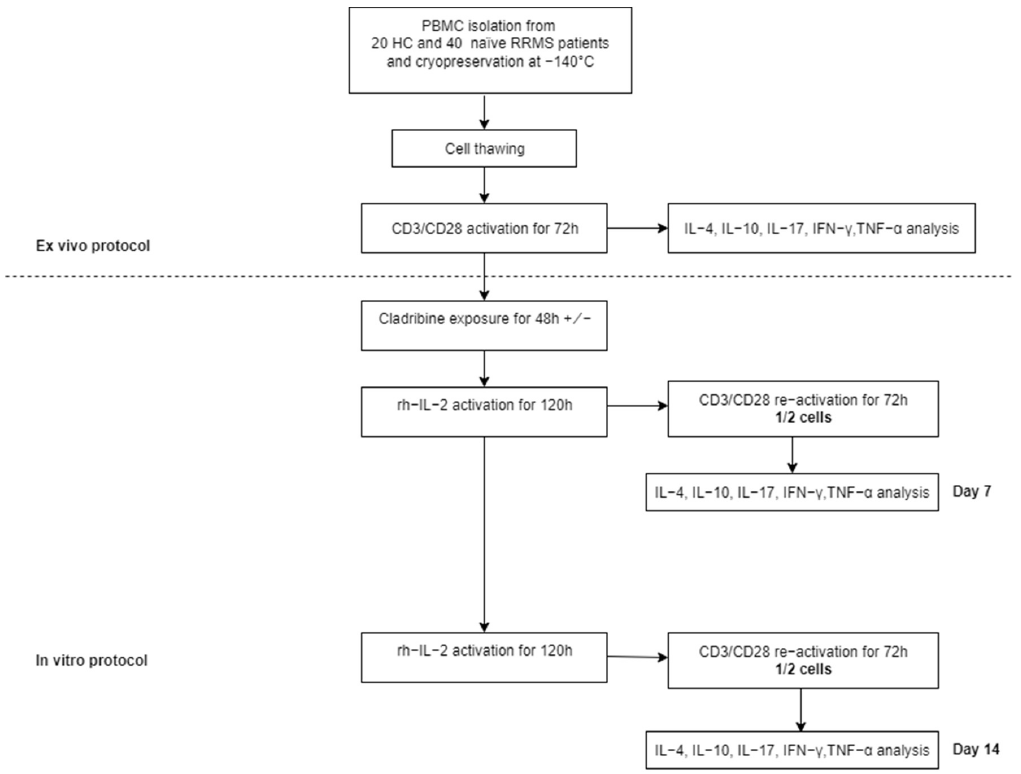
Figure 5. Study protocol.